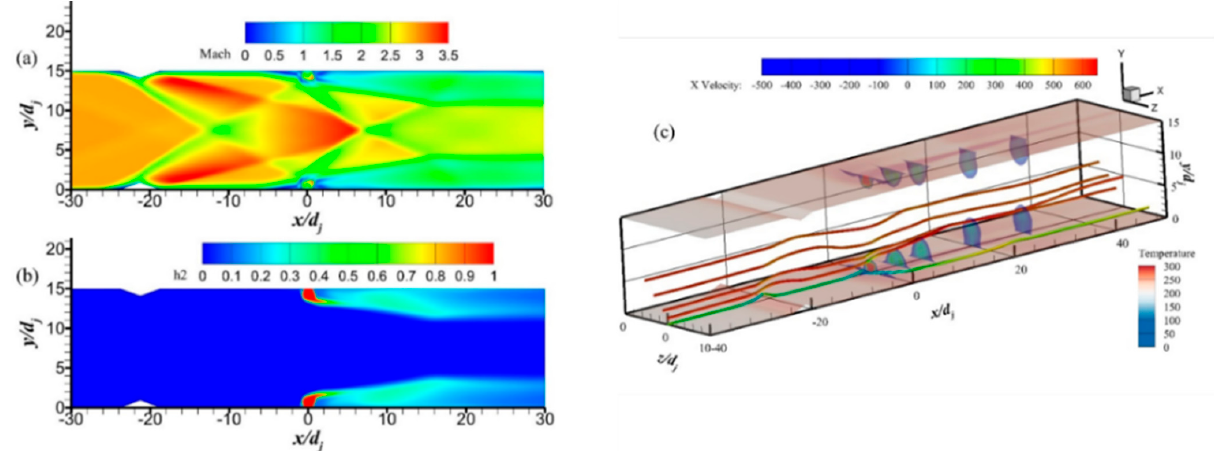
Figure 10. Flow field structure diagram of Case4. ( a ) Mach number contour. ( b ) Hydrogen mass fraction contour. ( c ) Diagram of streamline.